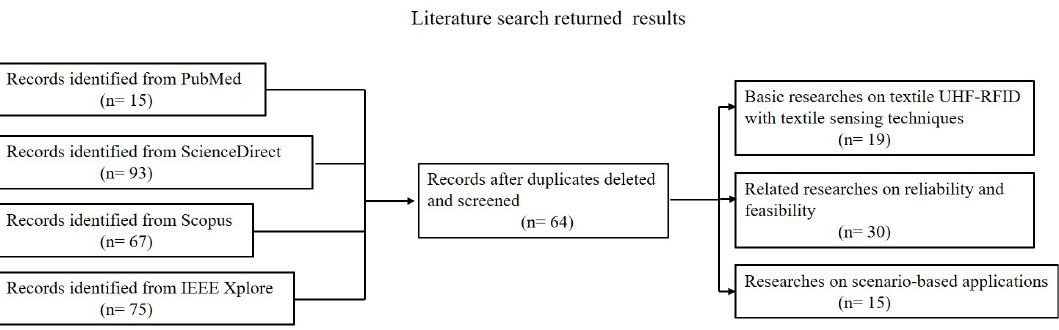
Figure 5. Flow diagram of paper